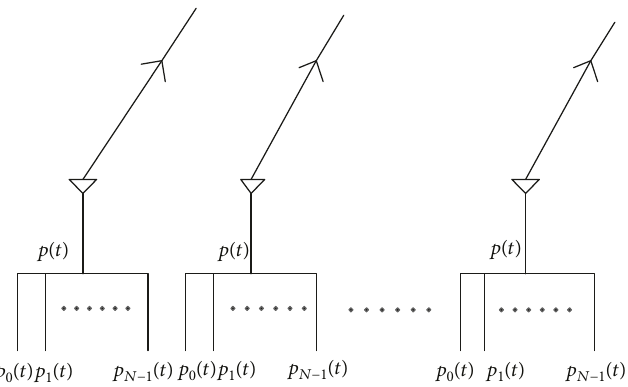
Figure 1: Allocation of transmitting